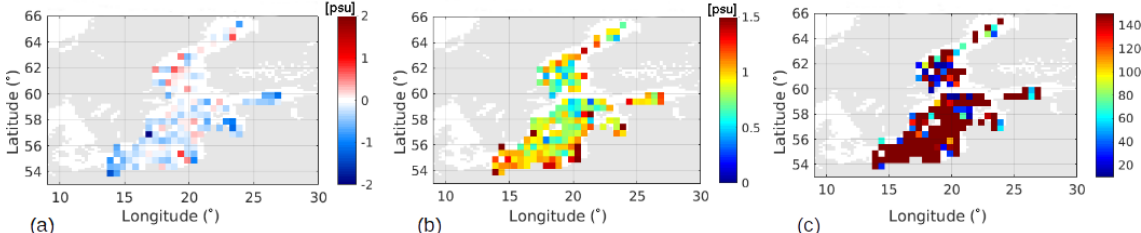
Figure 20. Comparison of L3 SSS and SDN: Spatial distribution of (cid:49) SSS [psu] with SDN in a coarser grid (0 . 5 ◦ ): (a) mean, (b) standard deviation, (c) number of match-ups.